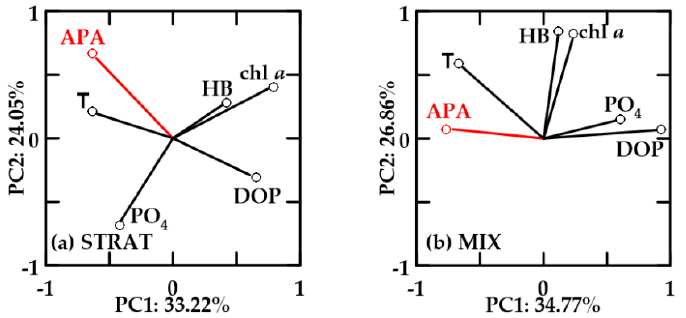
Figure 10. Principal component analysis (PCA) for relevant variables in oxygen ‐ saturated no ‐ FW waters during ( a ) STRAT and ( b ) MIX. Abbreviations are reported in Figure 8.